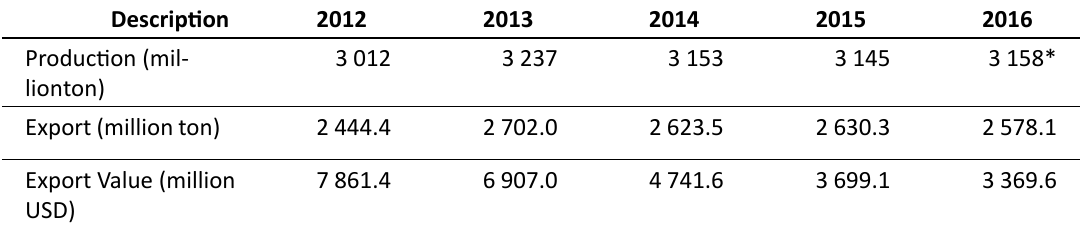
Table 2: Production, Export Volume, and Indonesian Value Export Natural Rubber,